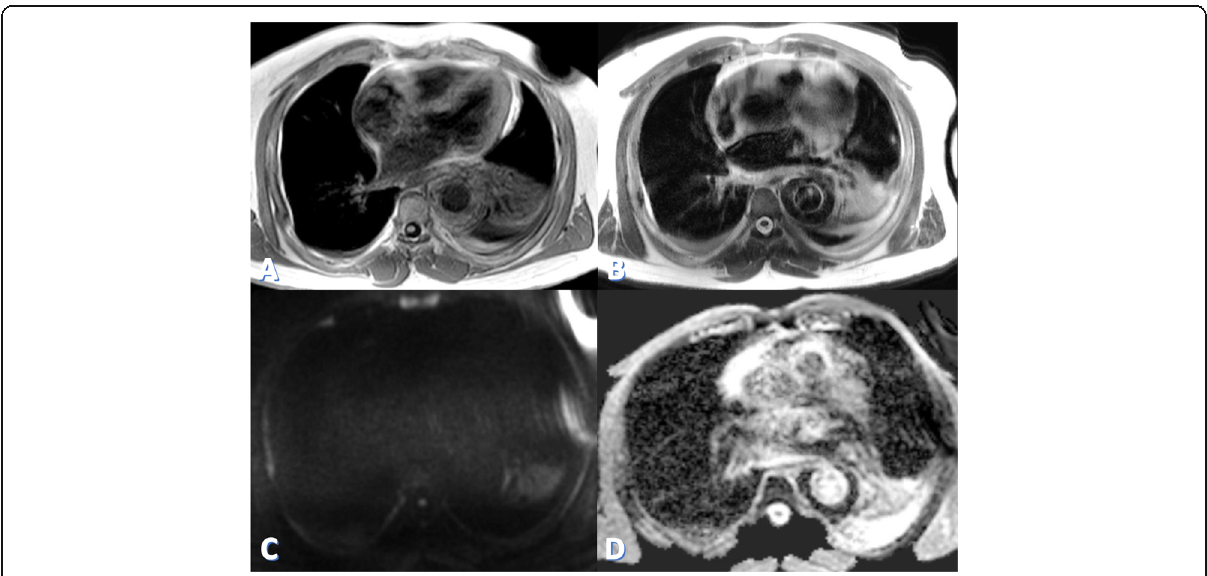
Fig. 2 a Axial T1 WI and b axial T2 WI showing left encysted pleural effusion displaying high T1 and T2 signal intensities. Associated finding of aortic intramural hematoma is noted eliciting high T1 and low T2 signal intensities. c DWI and d ADC map showing no evidence of diffusion restriction being bright on ADC map (ADC mean = 2.08 × 10 − 3 mm 2 /s). Ultrasound-guided aspiration cytology revealed blood cells